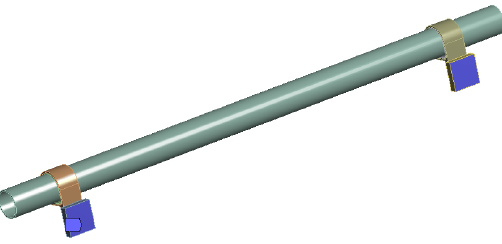
Figure 5. Schematic diagram of fixed constraints.